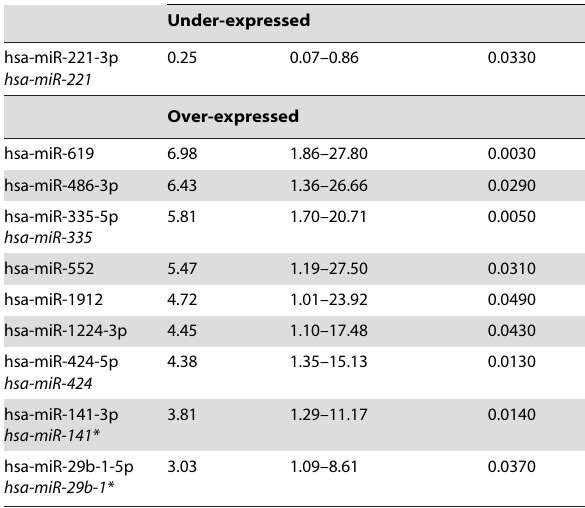
Table 4. Differentially expressed miRNA between patients who developed overt diabetic nephropathy relative to patients who did not.